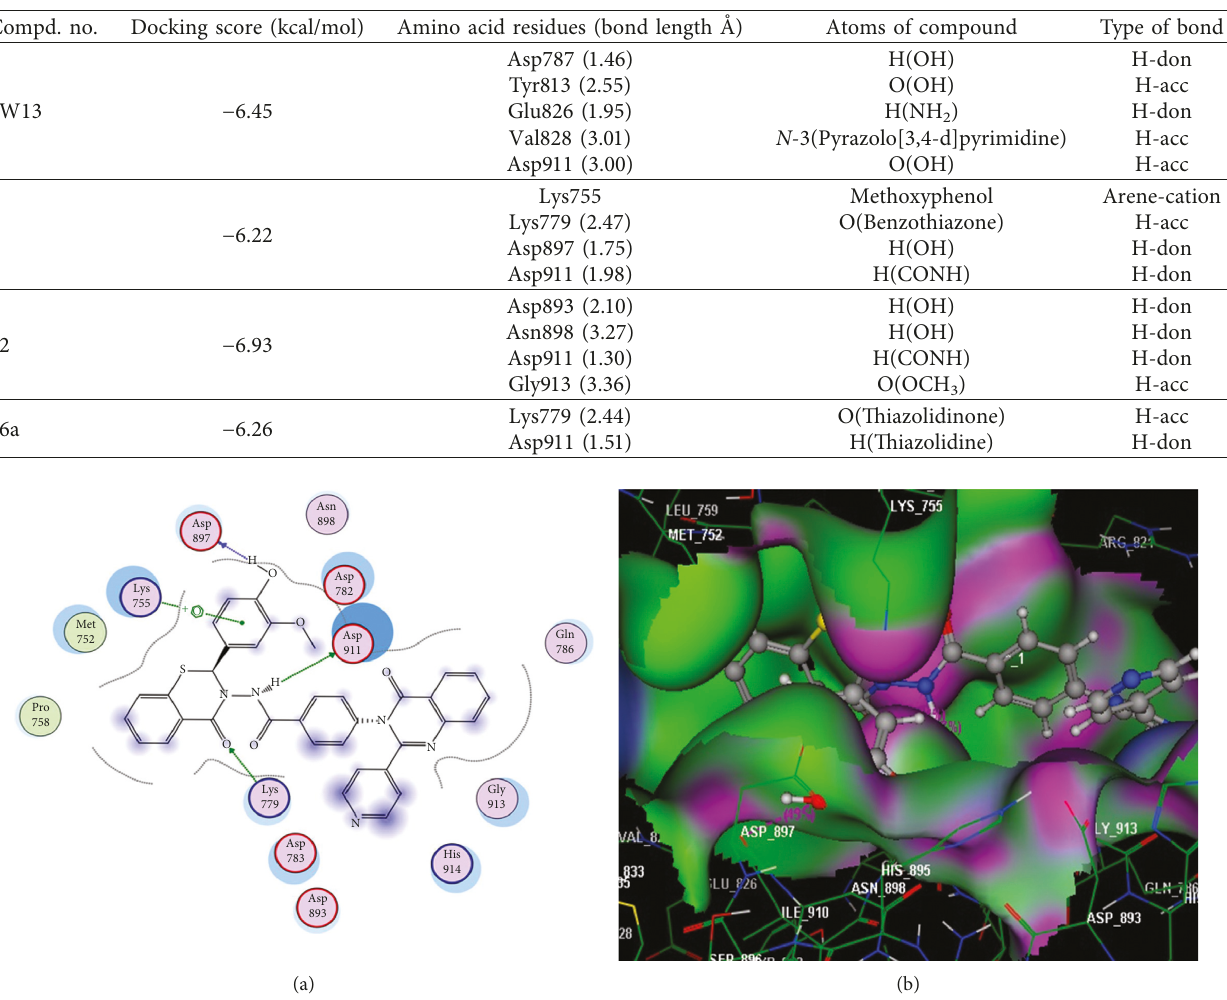
Figure 2: The suggested binding form of derivative 9 docked in the active position of PI3K showing (a) 2D and (b) 3D ligand-receptor interactions, respectively (H bonds are clarified as arrows; C atoms are colored gray; N atoms are colored blue; O atoms are colored red).